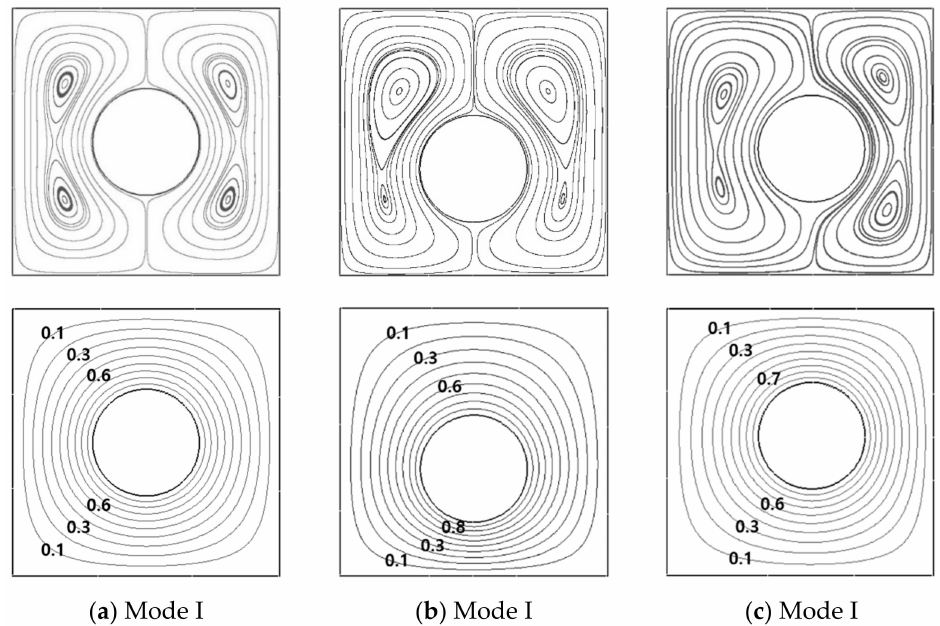
Figure 5. Streamlines (upper row) and isotherms (lower row) at ( a ) ( r = 0, θ = 0 ◦ ), ( b ) ( r = 0.1 L , θ = − 90 ◦ ) and ( c ) ( r = 0.05 L , θ = 30 ◦ ) for Ra = 10 3